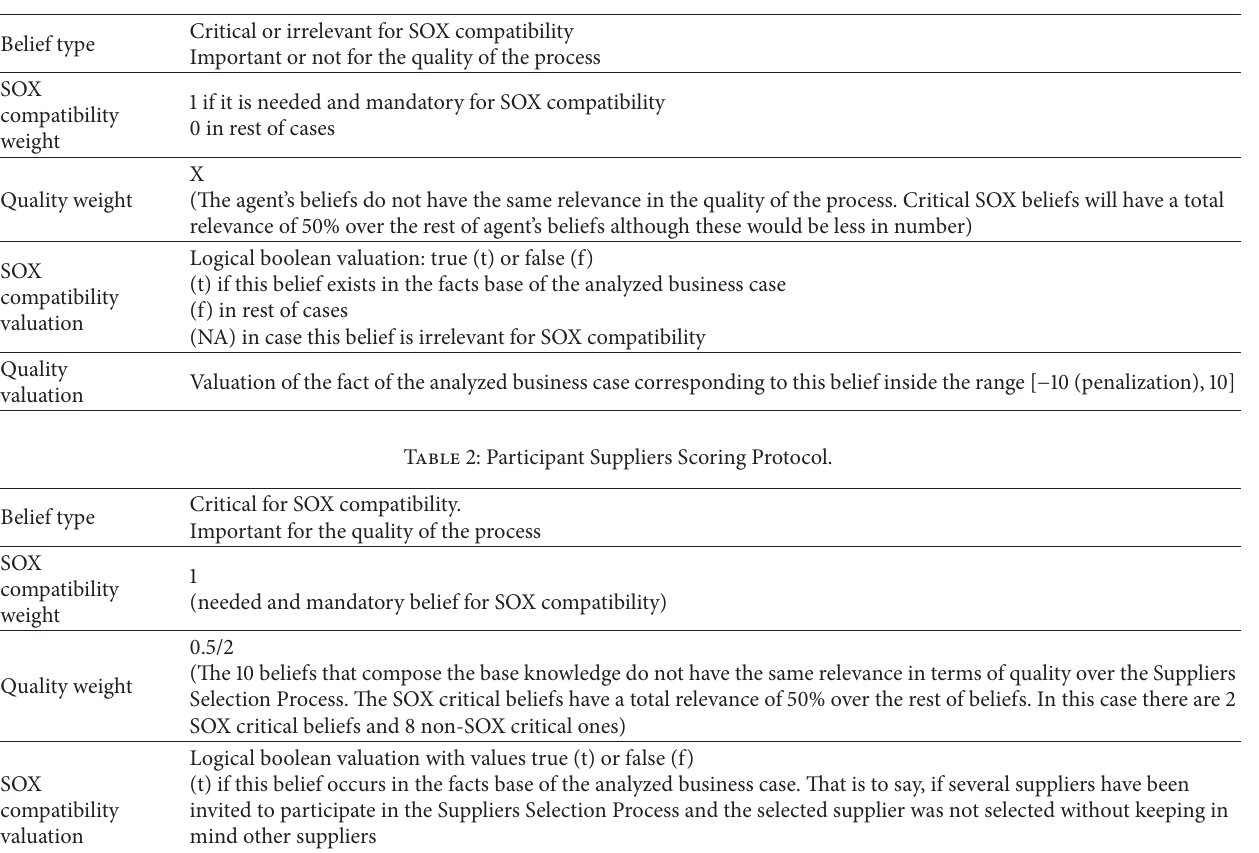
Table 1: Facts Scoring Protocol.